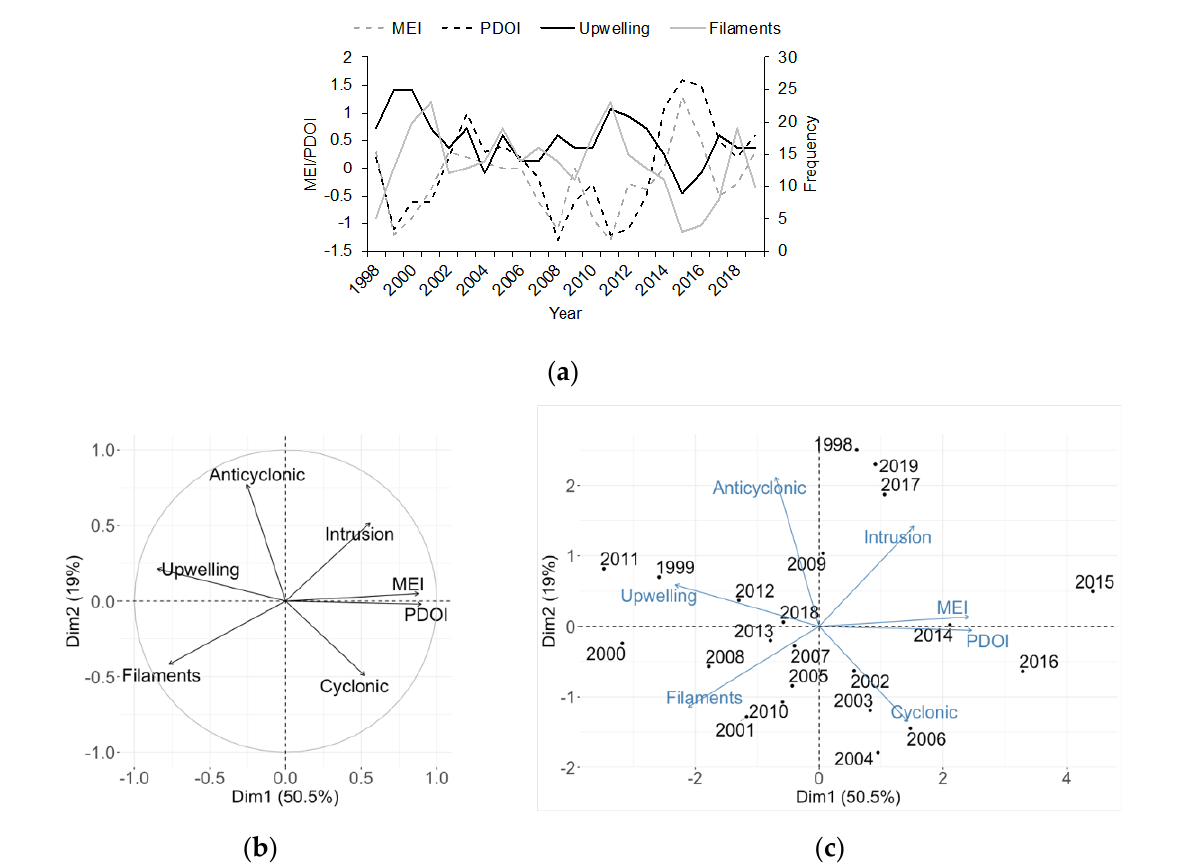
Figure 12. The Multivariate El Niño Index (MEI) and the Pacific Decadal Oscillation Index (PDOI) with the interannual variability in the Central Gulf of California of: ( a ) coastal upwelling frequency and filament frequency. Principal component analysis of oceanic mesoscale events, the Multivariate El Niño Index and the Pacific Decadal Oscillation Index in the Central Gulf of California; ( b ) Contribution of mesoscale events and climate indices to the first two principal components; ( c ) Contribution of each year (1998–2019) to the first two principal components. Table 2. Significantly associated variables within principal component 1 and 2 in the Central Gulf of